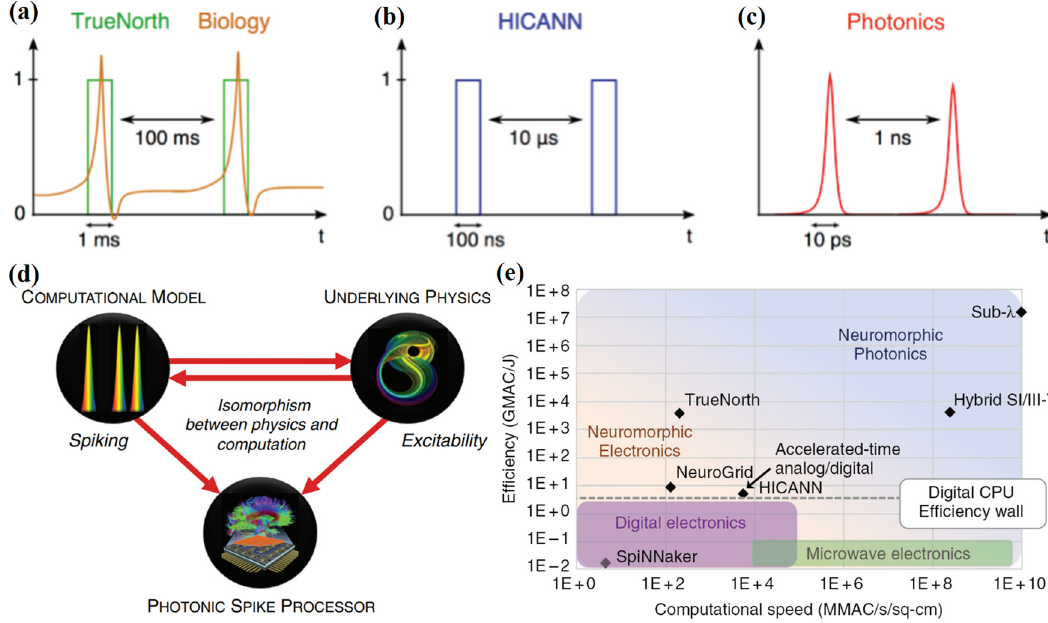
Figure 14: The physical time scales of ( a ) biological neurons, ( b ) electronic spiking neurons, and ( c ) photonic neurons. ( d ) Photonic spiking processor for optical computing analogies. Reproduced with permission from ref. [ 134 ] . Copyright 2017, Taylor & Francis Group. ( e ) Computational speed and e ffi ciency metrics of various neuromorphic hardware platforms, reproduced with permission [ 135 ] . Copyright 2017, Thomas Ferreira de Lima et al., published by De